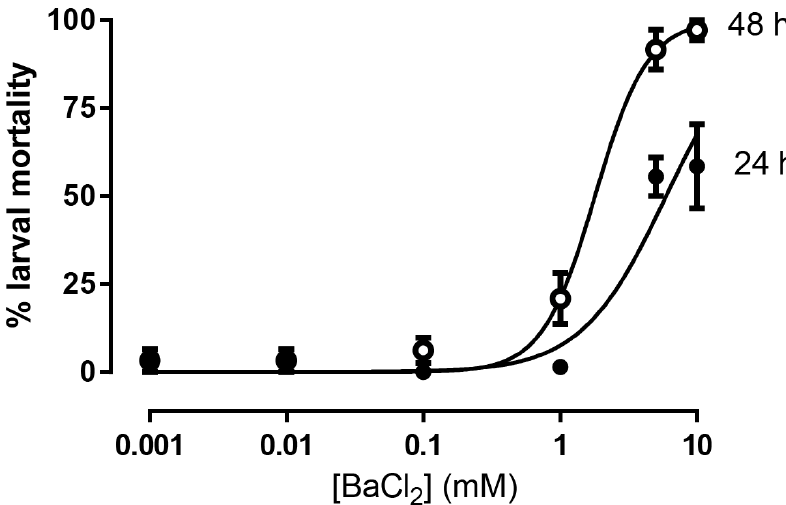
Figure 1. Concentration-toxicity relationship of BaCl 2 in first instar Aedes aegypti at 24 h and 48 h after addition to the rearing water (dH 2 O). Values are means ± standard error of the mean (SEM) based on six replicates of six larvae per concentration. Control mortality in dH 2 O without BaCl 2 was 0% within 24 h and 2.8 ± 2.8% within 48 h ( n = 6 replicates of 6 larvae). The 48 h LC 50 was determined with a ‘log(agonist) vs. normalized response-Variable slope’ curve fit in GraphPad Prism 6.